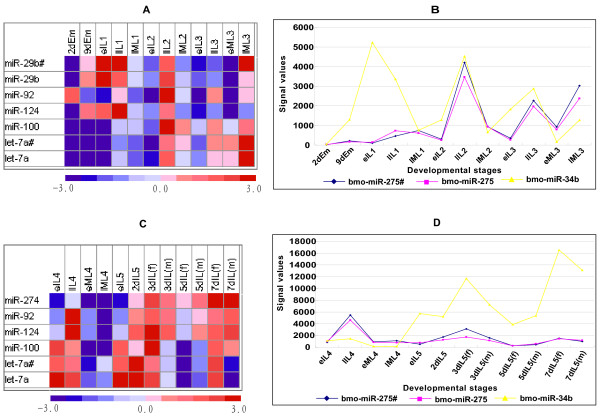
Microarray analysis of miRNA expression during the larval stages. (A) Stage-specifically expressed miRNAs during the early larval stages. (B) Comparison of the expression profiles of miR-275 and miR-34b during the early larval stages. (C) Stage-specifically expressed miRNAs during the late larval stages. (D) Comparison of miR-275 and miR-34b expression profiles during the late larval stages.